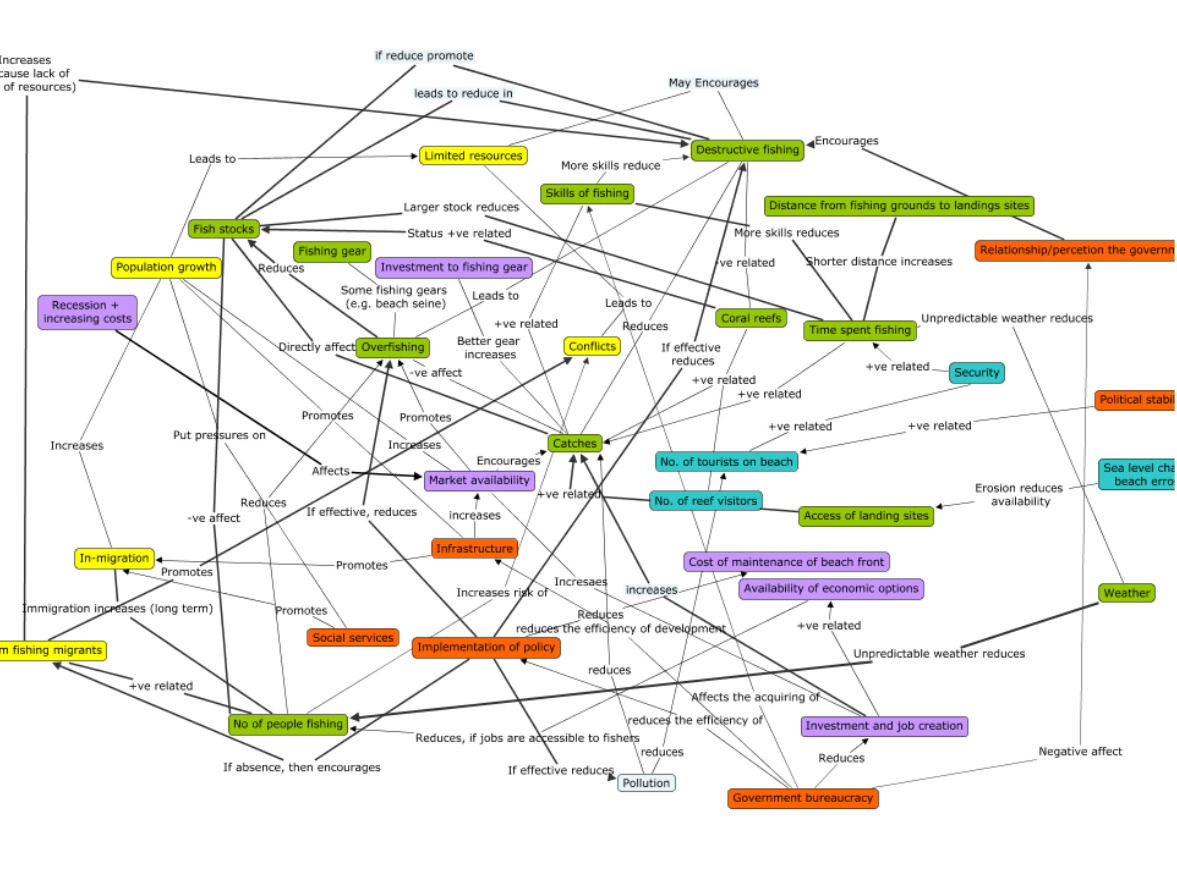
Figure S5. Yellow: Population, Orange: Governance, Purple: Economy, Blue: Tourism, Green: